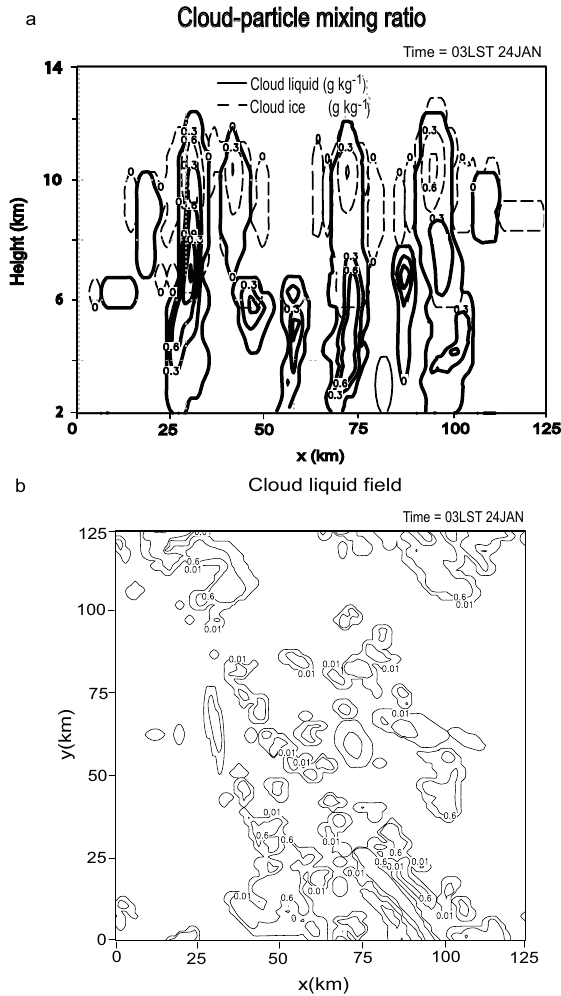
Fig. 6. (a) Contours of cloud-liquid (solid thick line) and cloud-ice (dashed line) mixing ratio (gkg − 1 ) and (b) horizontal distribution of the averaged cloud-liquid mixing ratio over the vertical domain at the time of the occurrence of maximum precipitation rate for the low-aerosol run in CONTROL. For (a) , contours are obtained in the middle of the y direction. Contour starts at 0gkg − 1 and contour interval is 0.3gkg − 1 . For (b) , contours are at 0.01 and 0.6gkg − 1